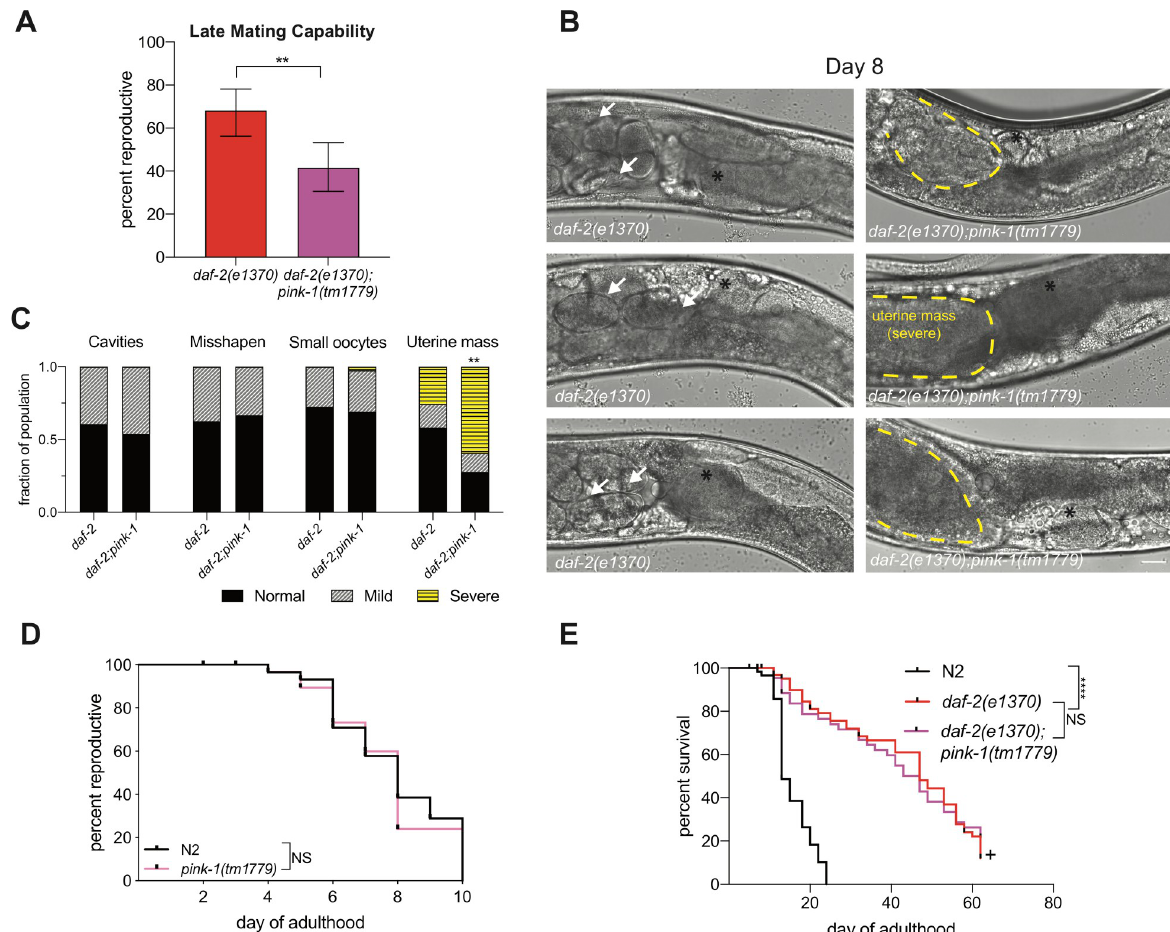
Fig 4. Mitophagy is required for daf-2 ’s extended reproductive capability. (A) Late-mating of daf-2(e1370) (n = 70) and daf-2(e1370);pink-1 (tm1779) (n = 66). Late-mating performed on age-matched Day 7 hermaphrodites provided with young males. Error bars represent 95% confidence interval. (B) Representative images of oocyte quality assay of daf-2(e1370);pink-1(tm1779) in aged adult germlines (Day 8). Highlighted features include: embryos in the uterus (white arrows), the -1 oocyte (black asterisk), uterine mass (yellow dotted outline). Scale bar is 20 μ m. (C) Quantification of oocyte quality phenotypes in daf-2(e1370) (n = 45) and daf-2(e1370);drp-1(tm1108) (n = 51). (D) There is no significant difference between the mated reproductive spans of N2 (n = 59) and pink-1(tm1779) (n = 63). (E) No change between the lifespan of daf-2(e1370); pink-1(tm1779) compared to daf-2(e1370) alone (n = 66–79). + indicates censorship due to covid-19 shutdown. �� p � 0.01, ���� p �